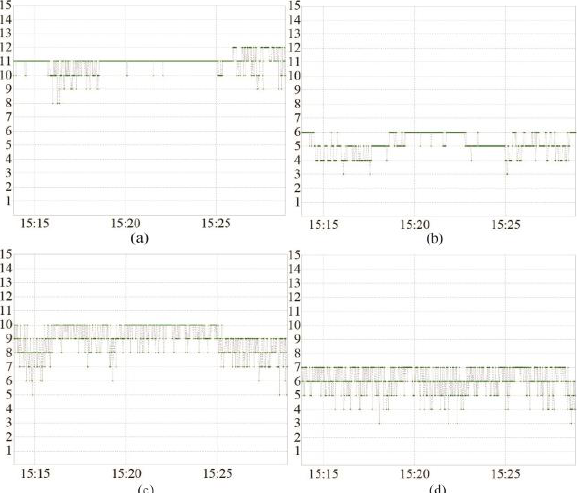
Figure 11 . The tracked satellites’ number of different constellations with elevation angles above 10° during the kinematic car-borne experiment. (a) is the number of tracked satellites for BDS. (b) is the number of tracked satellites for Galileo. (c) is the number of tracked satellites for GPS. (d) is the number of tracked satellites for